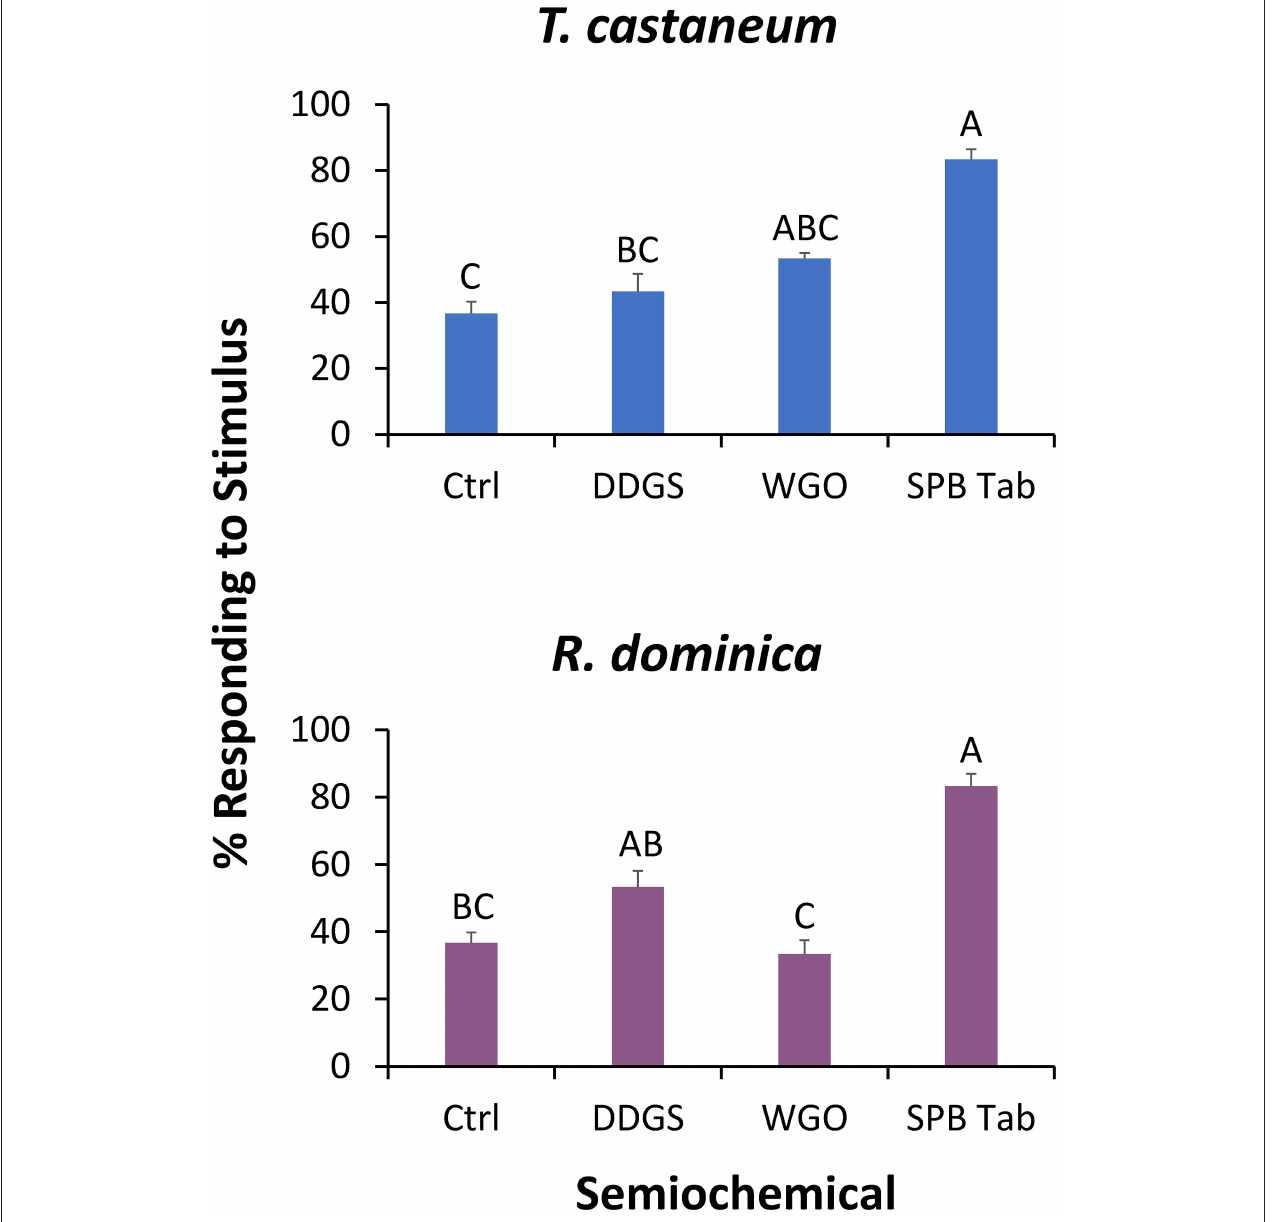
FIGURE 4 | The percentage of T. castaneum (top) and R. dominica (bottom) exiting the release arena on the stimulus (upwind) edge in a wind tunnel assay. These stimuli included dried distillers’ grains with solubles (DDGS), wheat germ oil (WGO), the commercial lure Stored Product Beetle Tab (SPB Tab), and ambient air (Ctrl). Bars with shared letters are not significantly different from each other ( χ 2-tests, Bonferroni